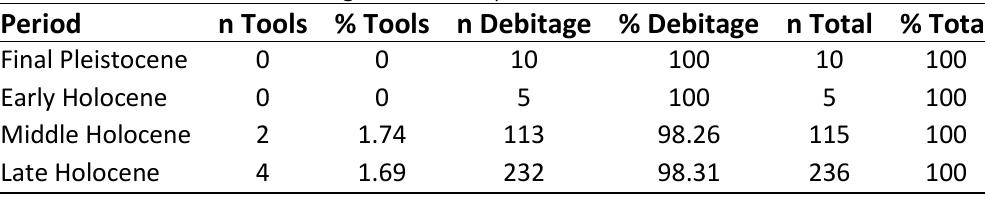
Table 3. Structure of the assemblag es from each period.